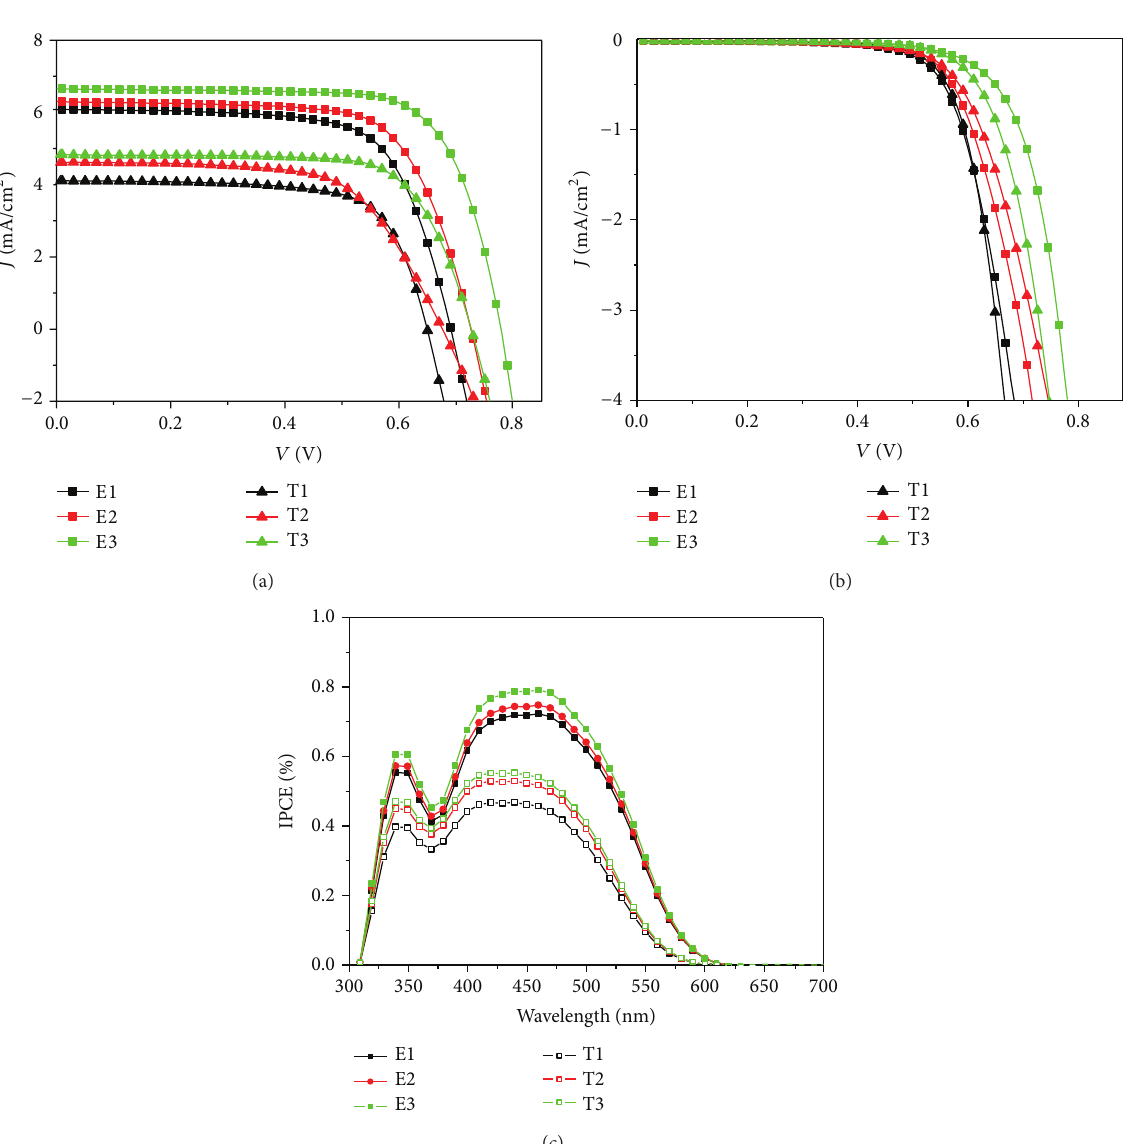
compared with the EtOH measured under AM 1.5 simulated sunlight illuminations with the light intensity 100 mW/cm